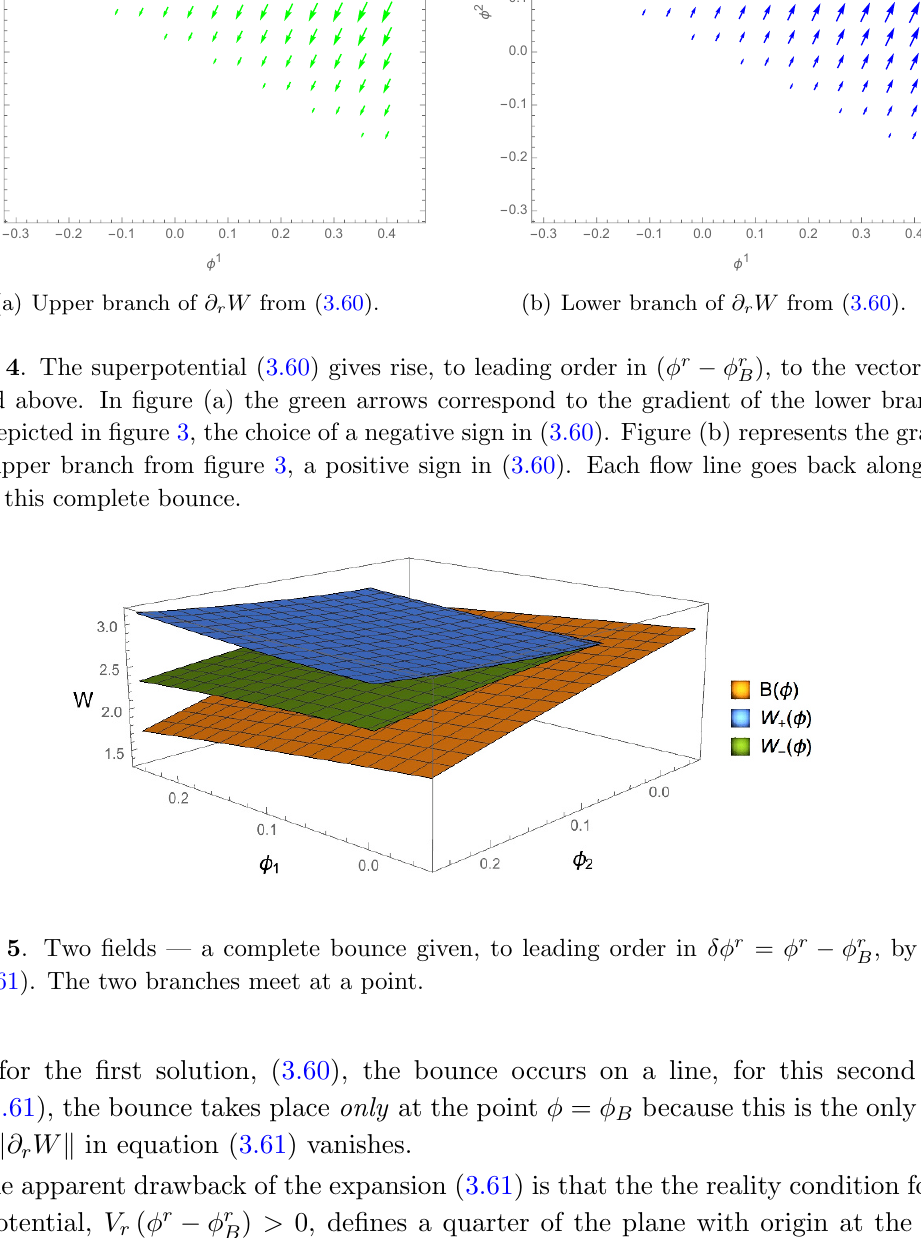
Figure 5 . Two (cid:12)elds | a complete bounce given, to leading order in (cid:14)(cid:30) r = (cid:30) r (cid:0) (cid:30) r tion (3.61). The two branches meet at a